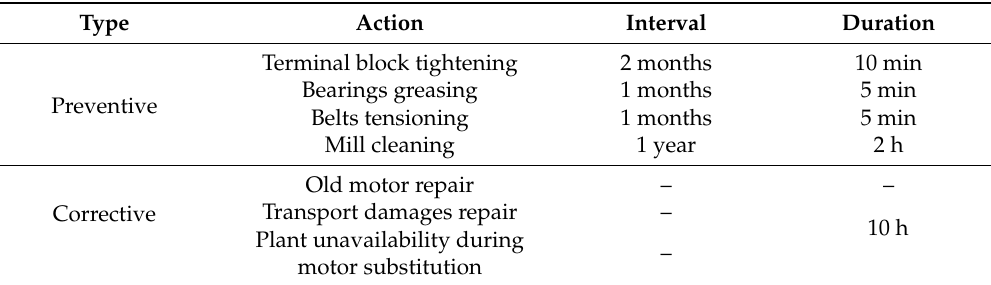
Table 2. Maintenance activities.